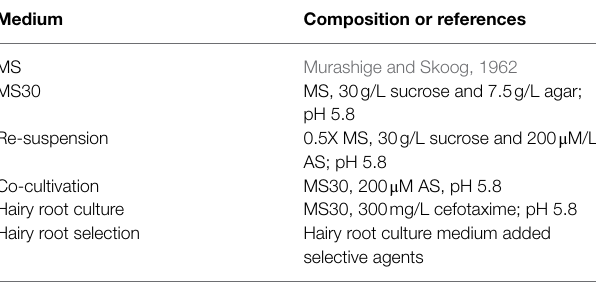
TABLE 1 | The list of media used in cucumber hairy root